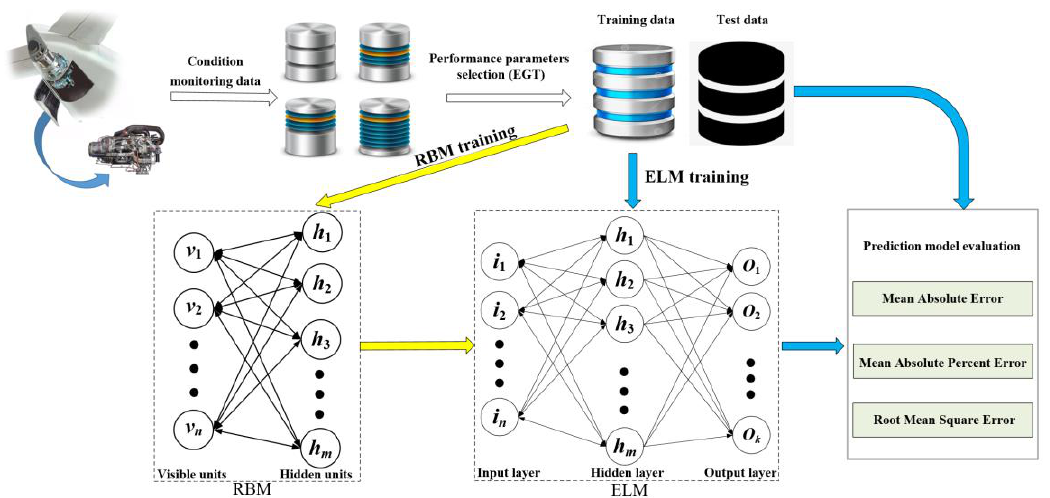
Figure 1. Diagram of the proposed method. EGT: exhaust gas temperature; RBM: restricted Boltzmann machine; ELM: extreme learning machine.